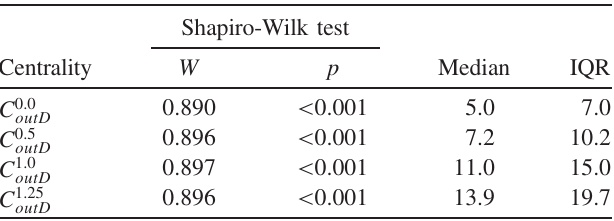
TABLE V. The summary of the descriptive statistics for the outdegree centrality from fourth collection ( N ¼ 53 ). Based on the Shapiro-Wilk test, the null hypothesis about the normal distribution is rejected for all centralities.